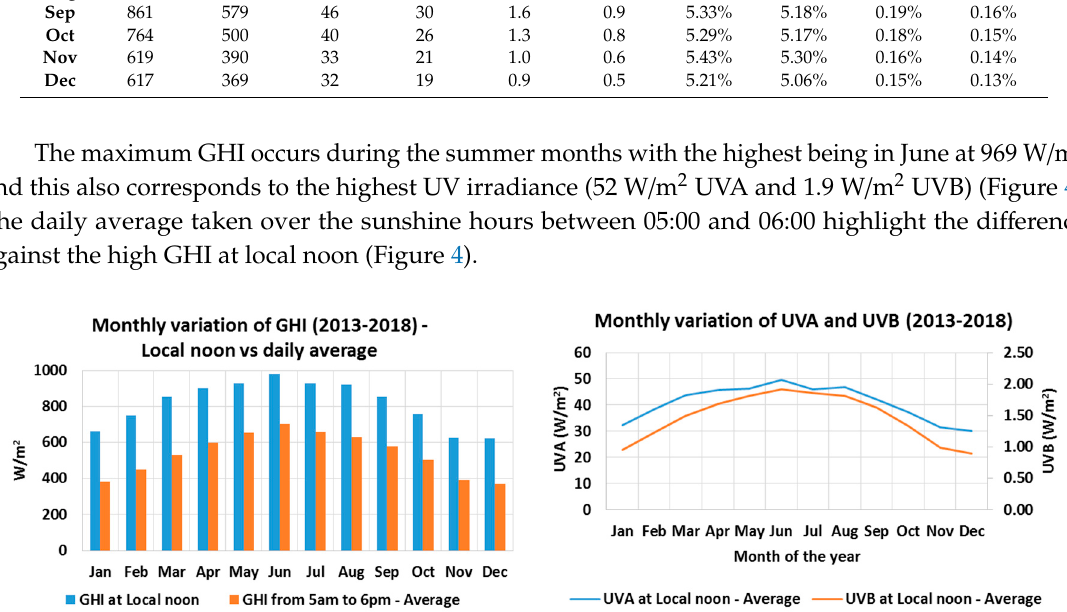
GHI (W / m 2 ) UVA (W / m 2 ) Table 1. Monthly variation of solar irradiance parameters for Doha, between 2013 and 2018— comparison between values at local noon and those averaged throughout the intraday sunshine hours (05:00 to 06:00) . GHI (W/m 2 )